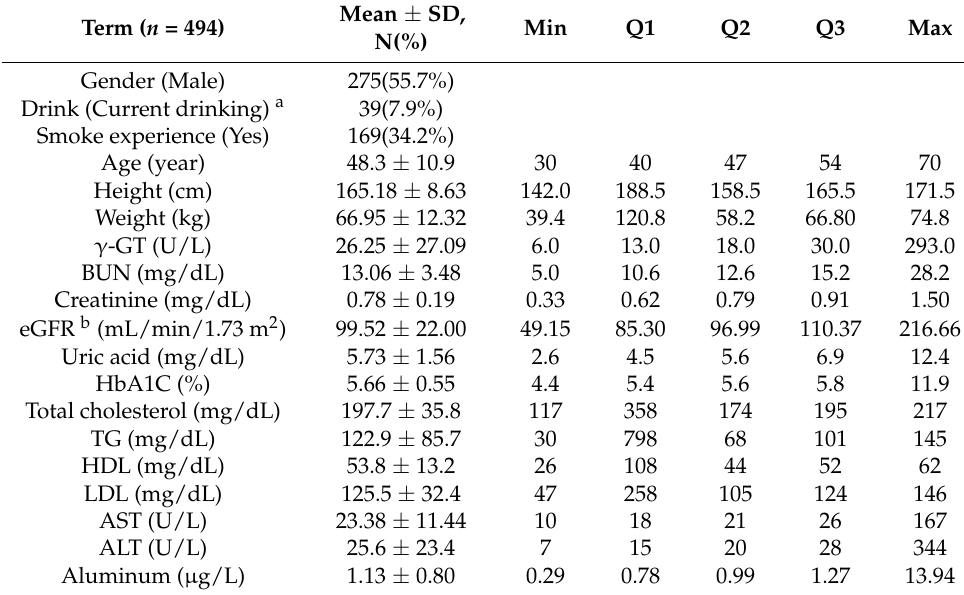
Table 1. Characteristics of study population.